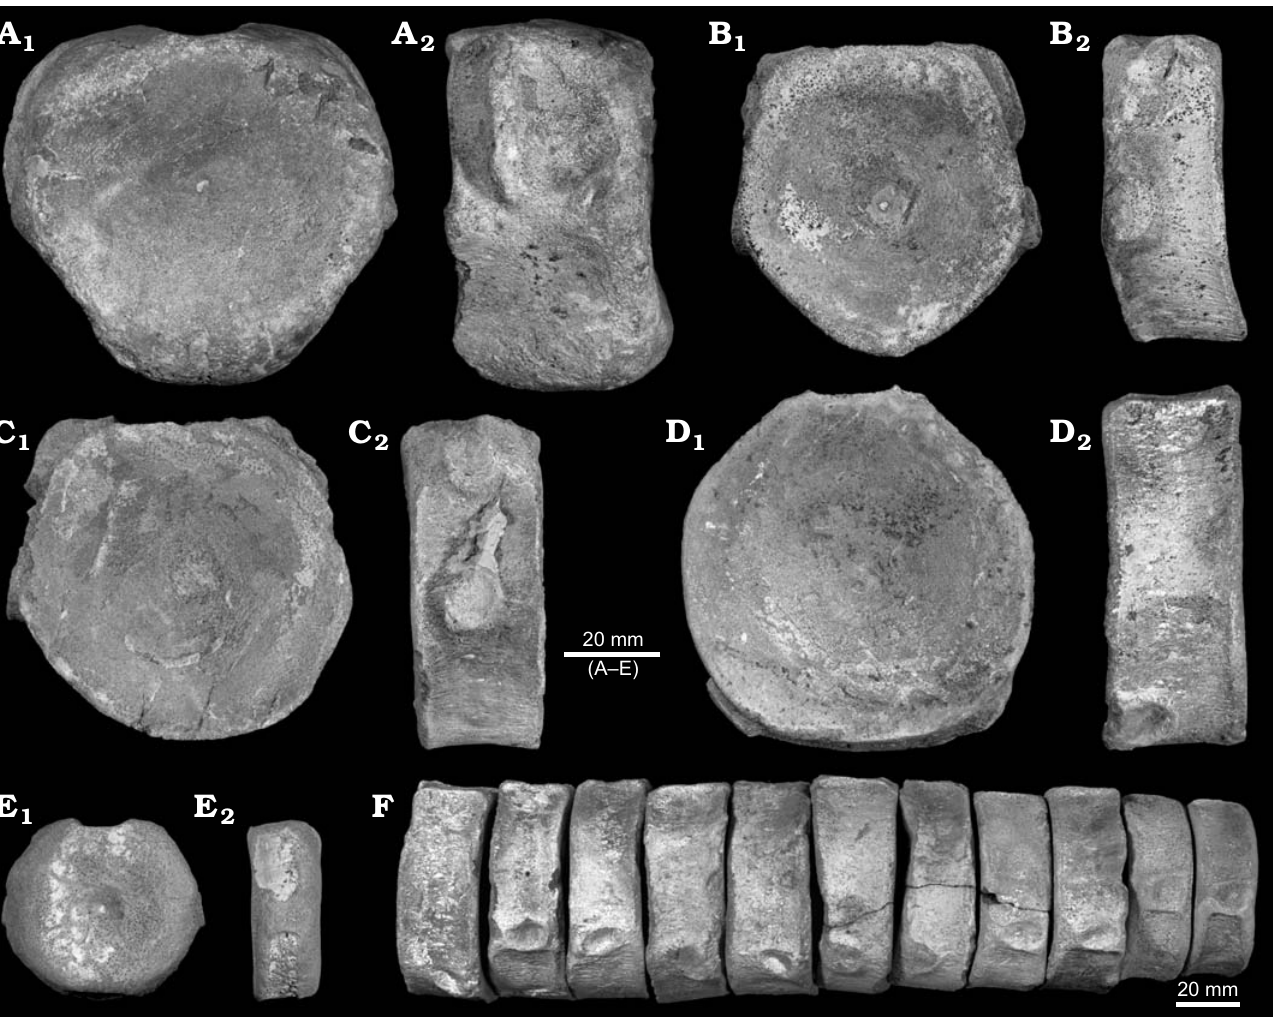
Fig. 5. Morphology of isolated centra of ophthalmosaurid ichthyosaur Cryopterygius kielanae sp. nov. (GMUL 3579-81, holotype) from the Late Jurassic of Owadów-Brzezinki Quarry. Atlas-axis complex ( A ), cervical ( B ), dorsal ( C ), preflexural caudal ( D ), and postflexural caudal ( E ) centra, preflexural caudal spine ( F ); in anterior (A 1 –E 1 ) and left-lateral (A 2 –E 2 , F)